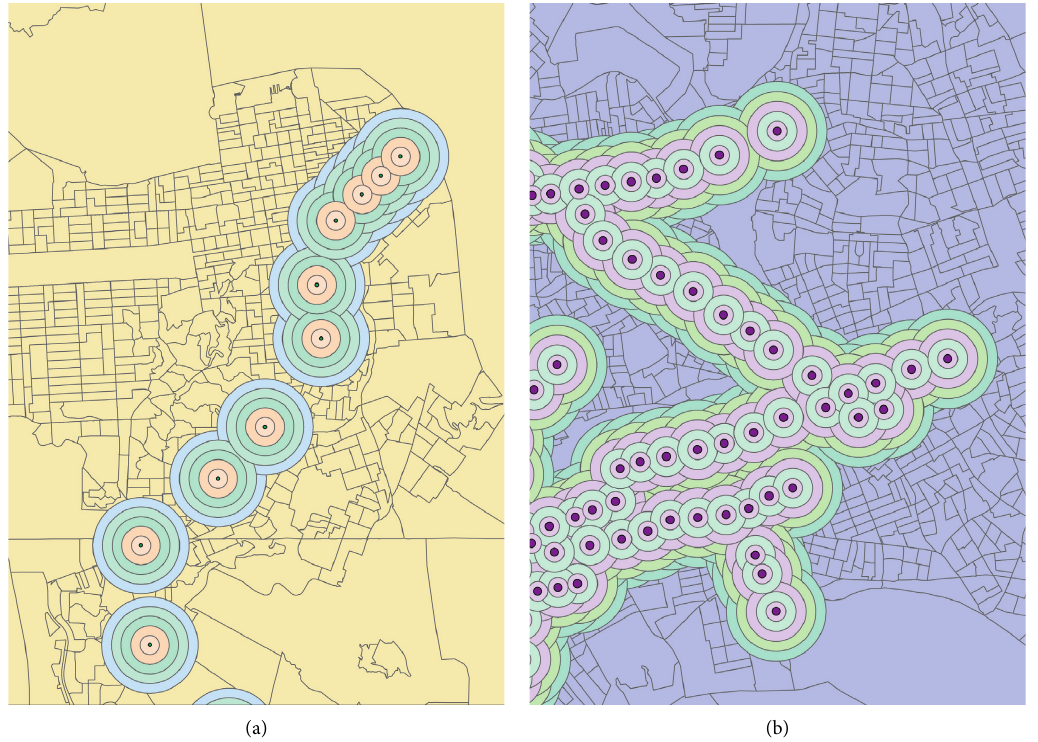
Figure 2: Overlapping buffer area of some stations in the Bay Area (a) and New York